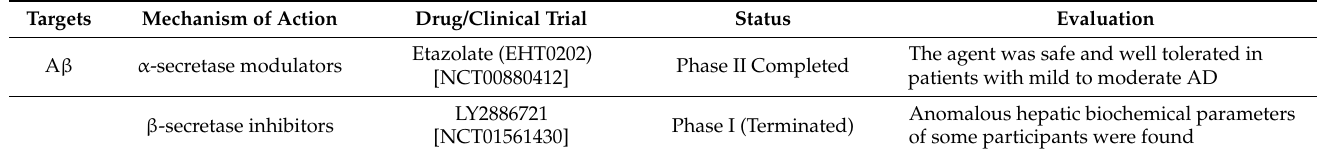
Table 1. Current pharmacological treatment of AD (clinicaltrials.gov accessed on: 29 November